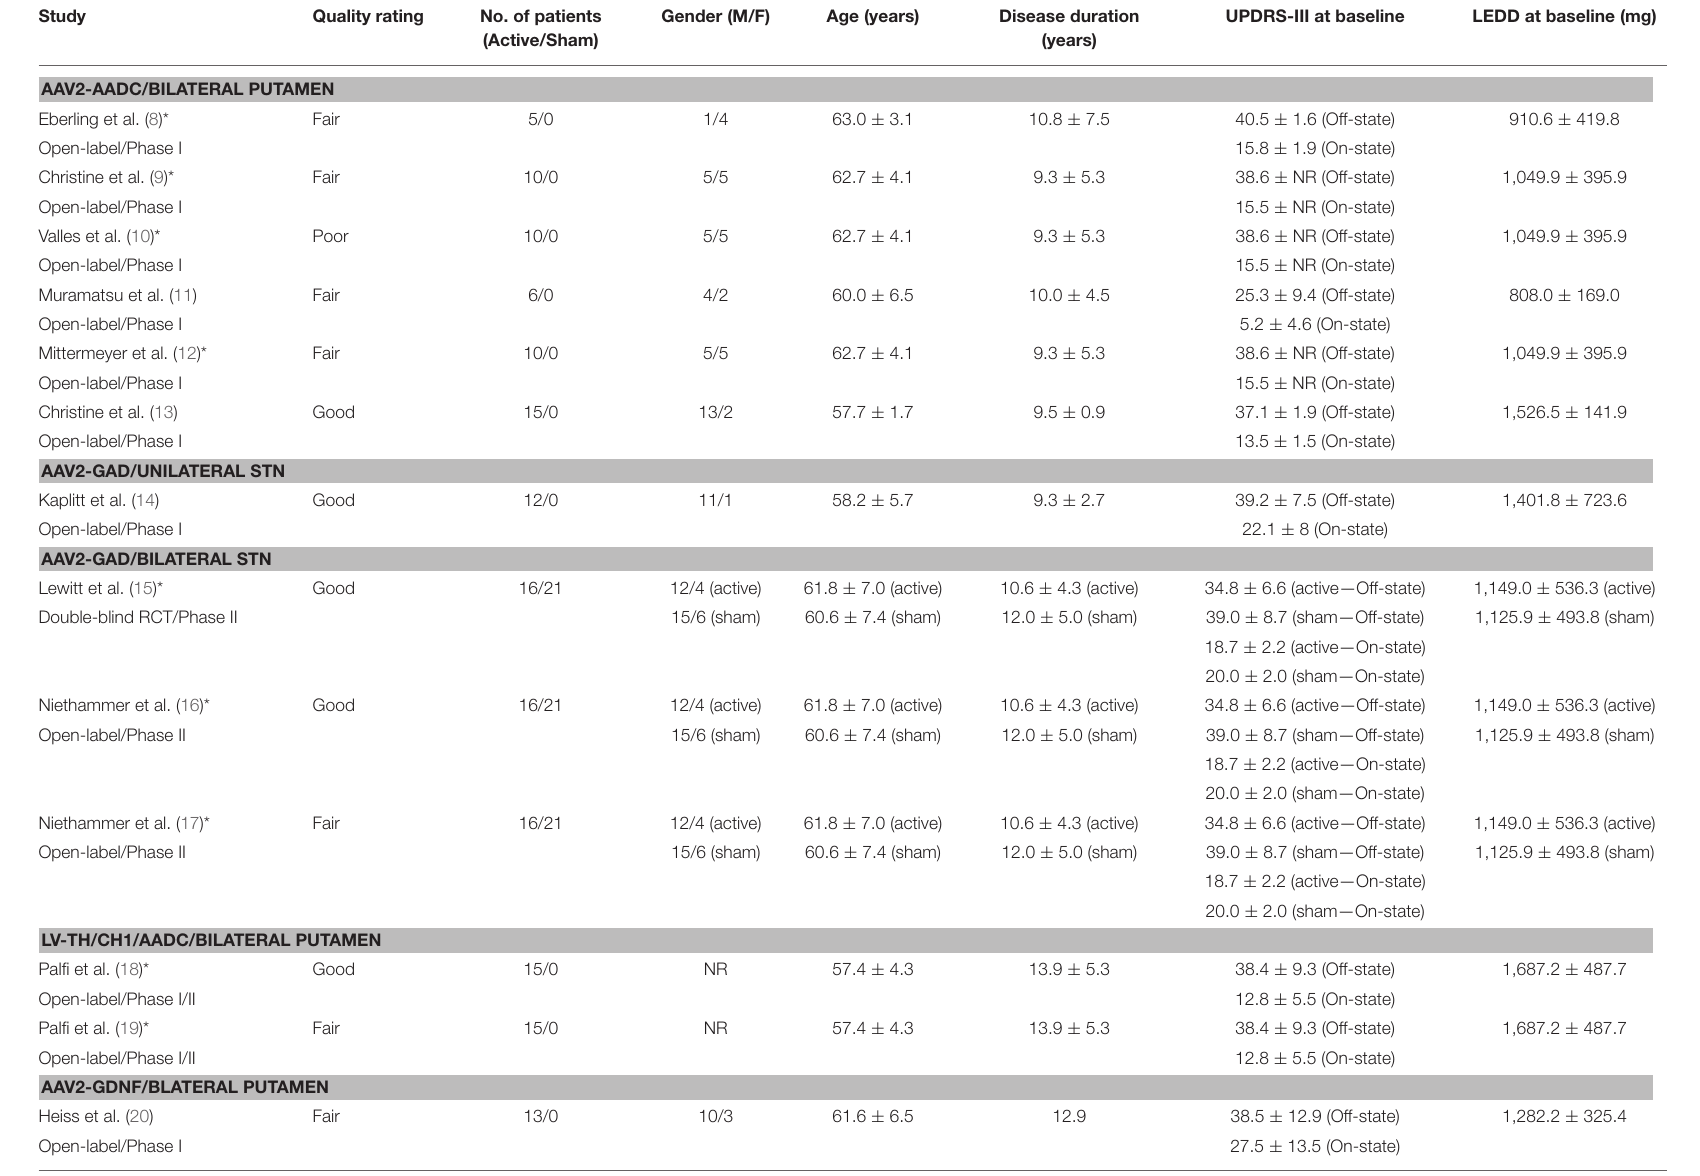
TABLE 1 | Reviewed articles—baseline features—Parkinson disease.